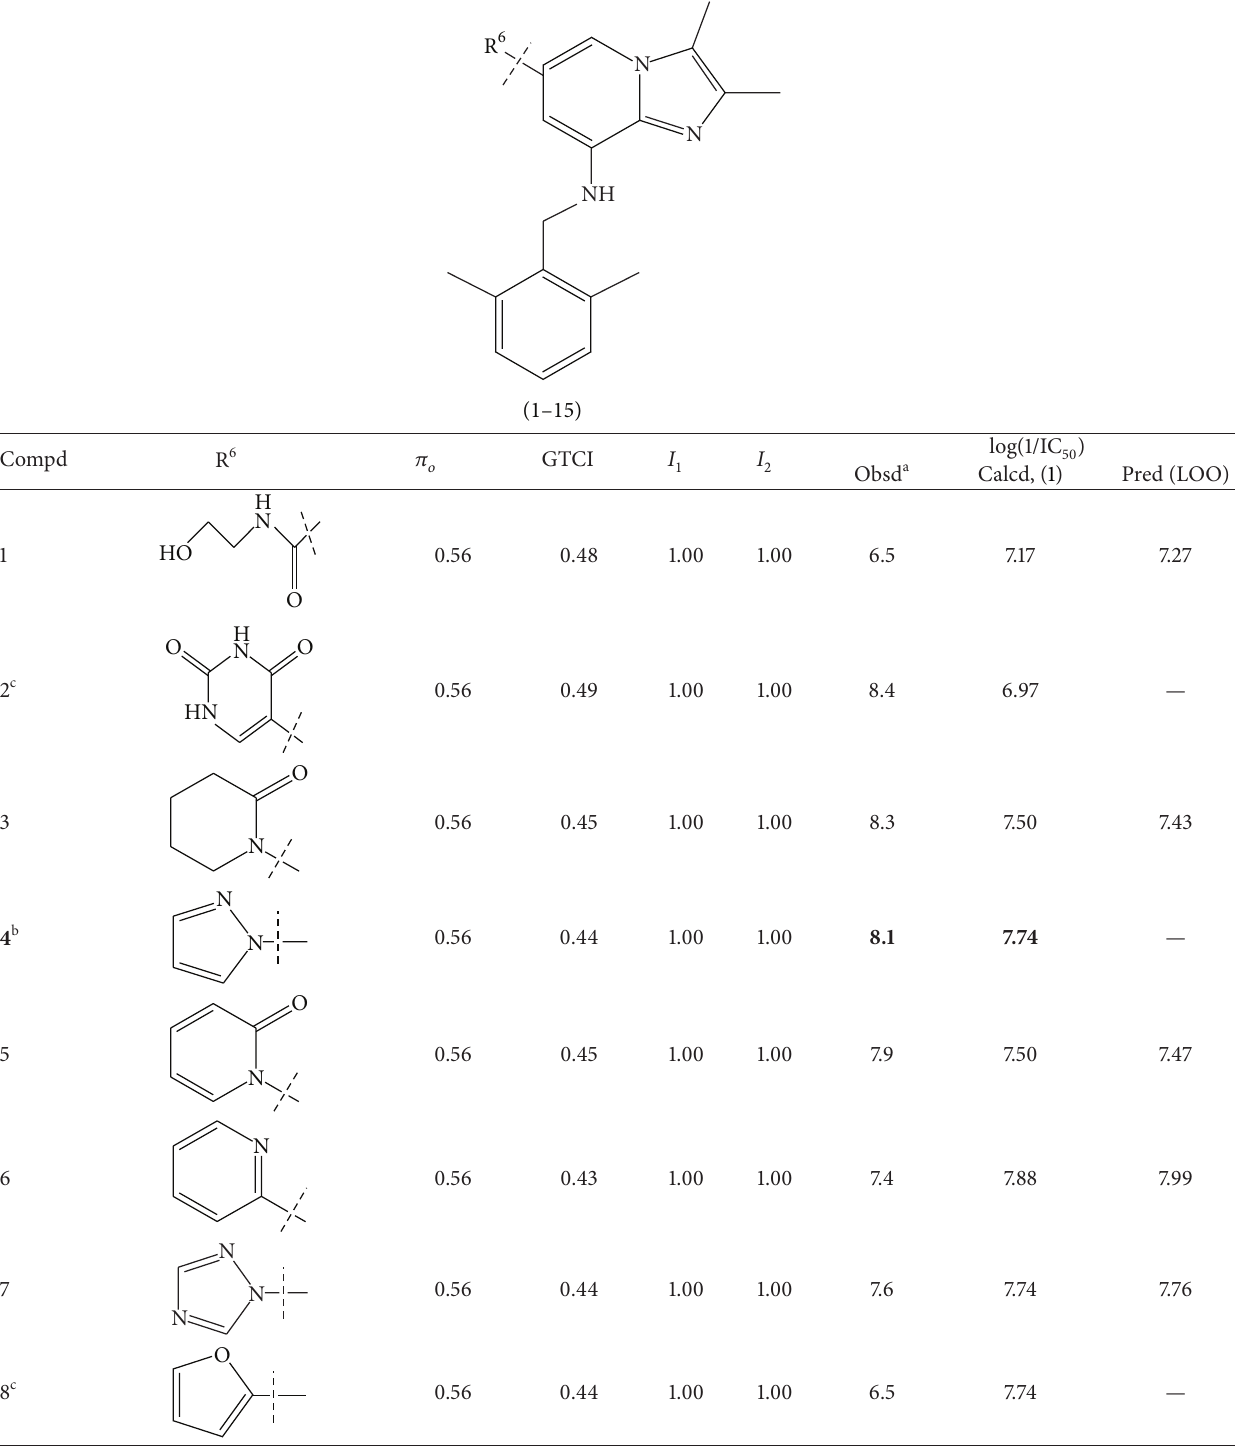
Table 1: Heteroaryl- and heterocyclyl-substituted imidazo[1,2-a]pyridine derivatives and their physicochemical parameters and H + /K + - ATPase inhibition